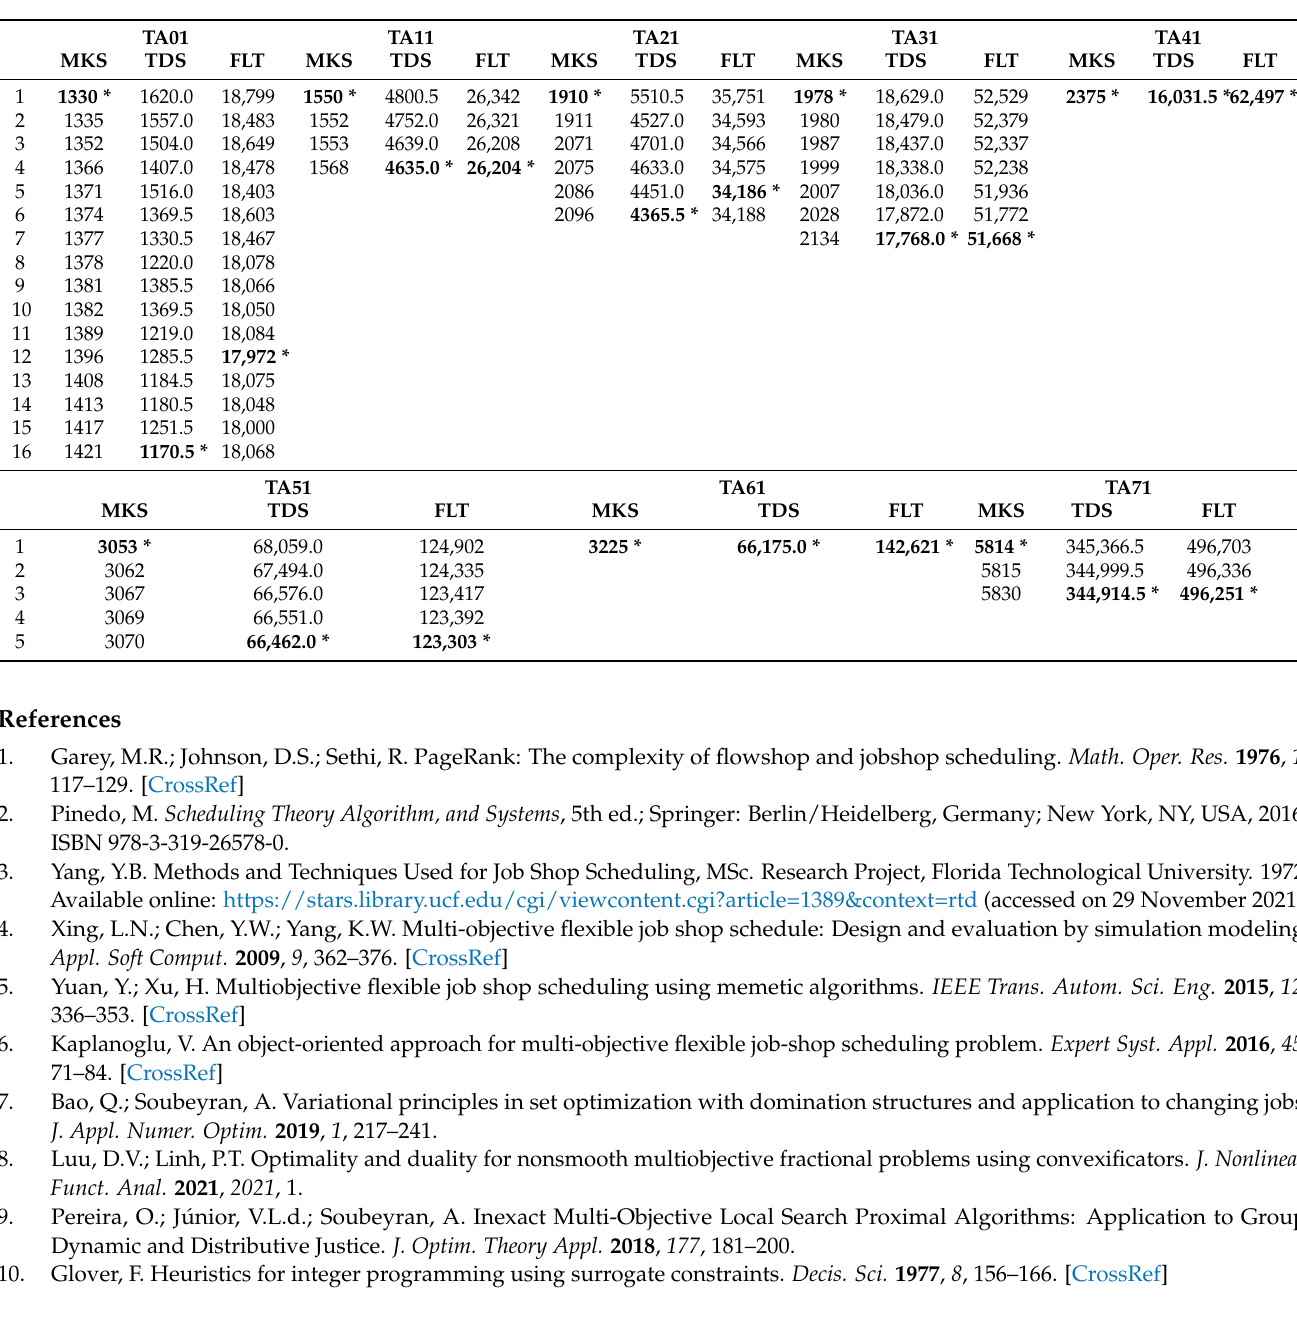
Table A21. Non-dominated solutions obtained by SS/CMOTA for the JSSP instances proposed by